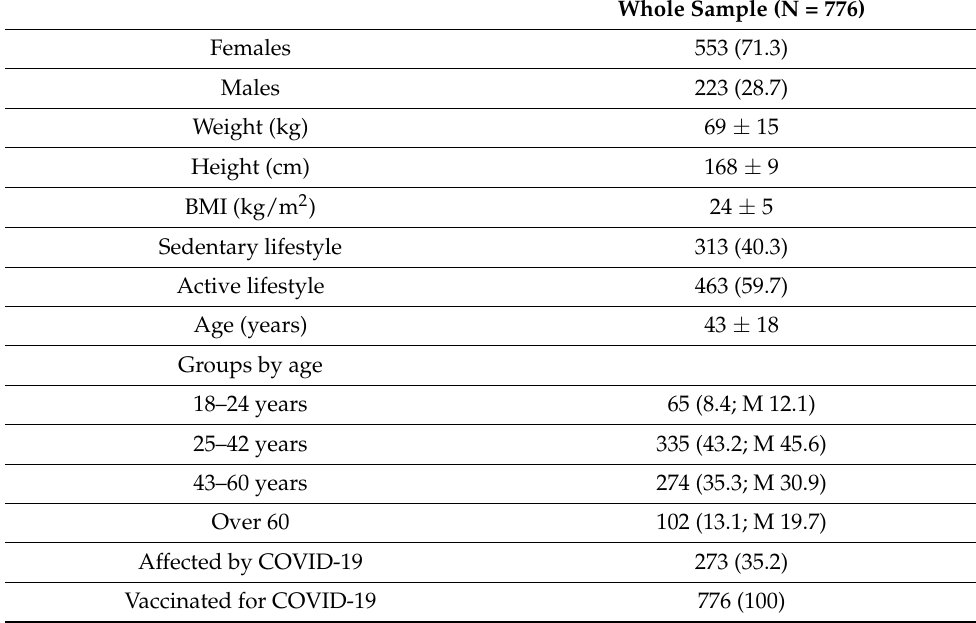
Table 1. Participants’ general characteristics and